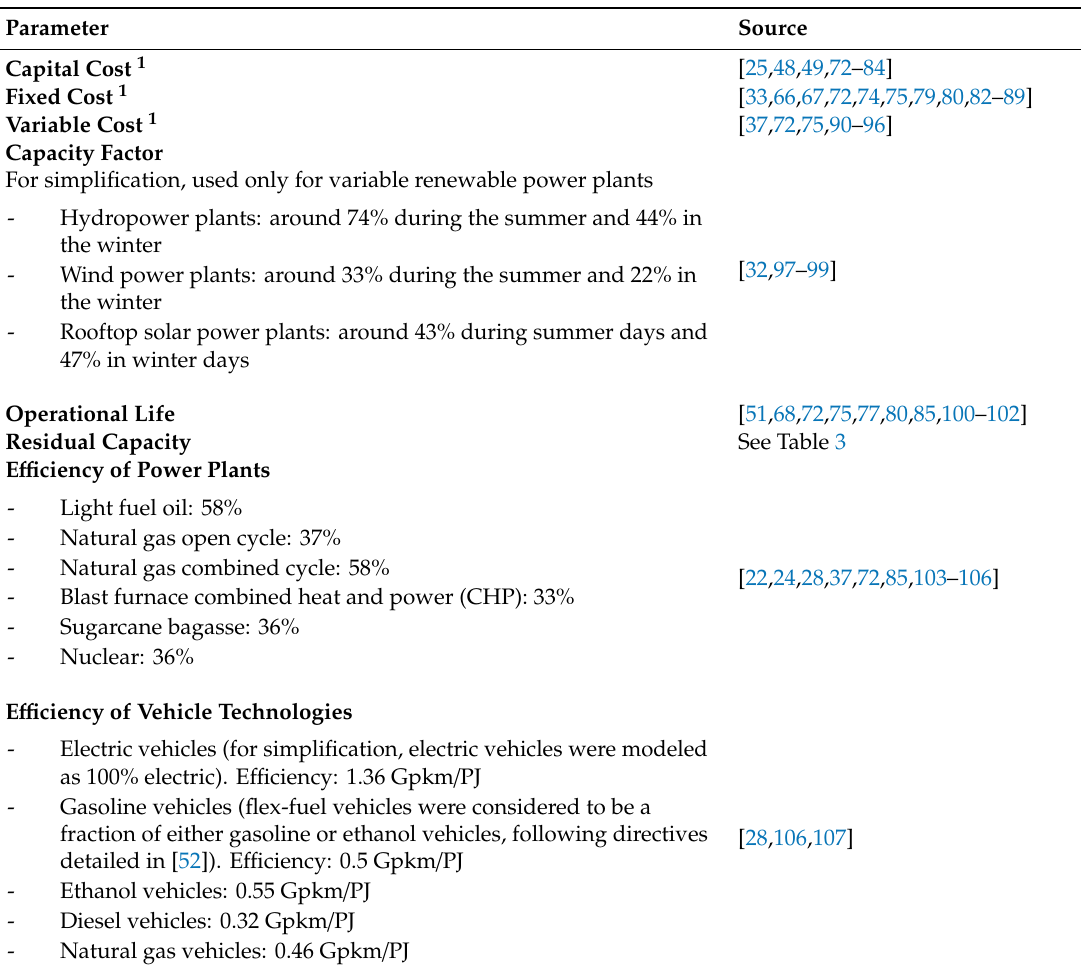
Table A1. Data sources for the parameters used in the